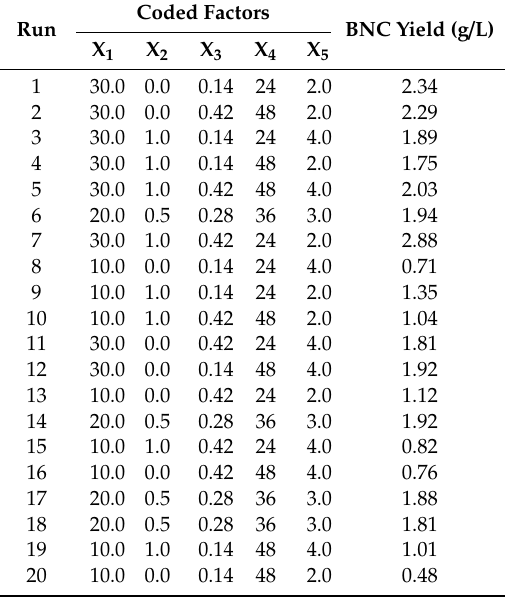
Table 2. Factor levels evaluated in the screening design and results of the bacterial nanocellulose (BNC) yield at each level.